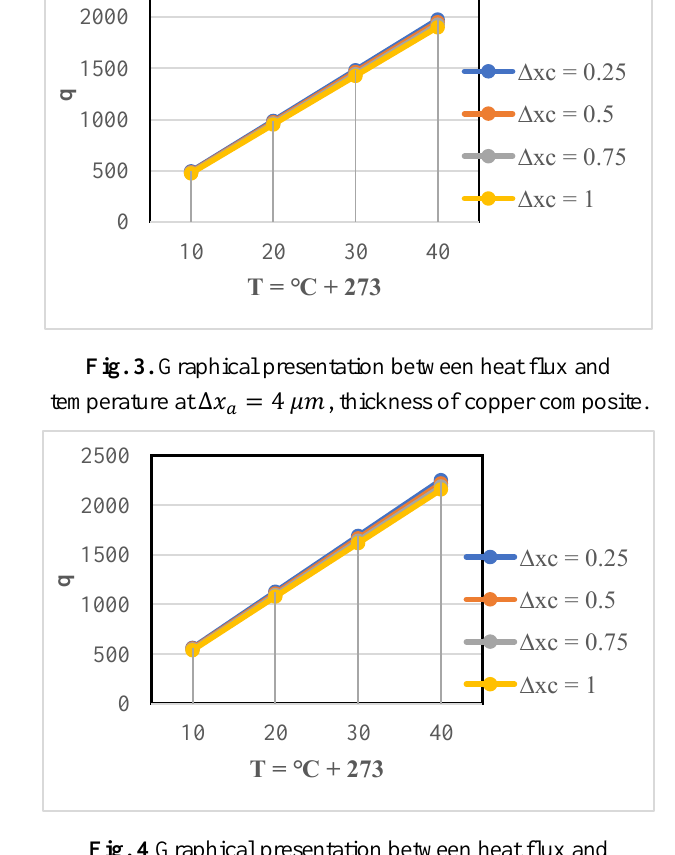
Fig. 4 Graphical presentation between heat flux and temperature at ∆𝑥 = 3 𝜇𝑚 , thickness of copper 𝑎